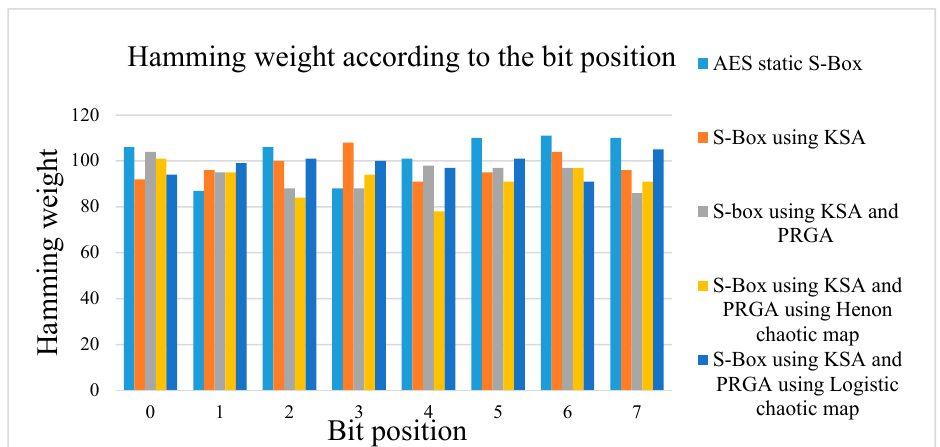
Table 7. Results with the key “ F9E8D7C6B5A40123”.